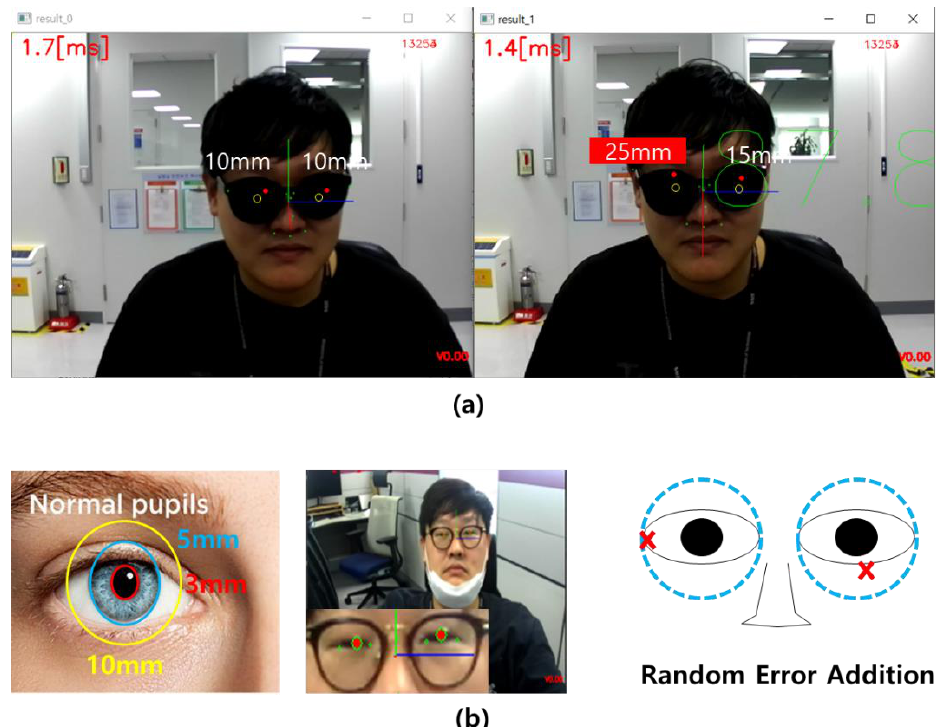
Figure 8. Participant-based experiments assessing the susceptibility of the proposed method to 3D crosstalk for users wearing sunglasses. ( a ) Examples of eye-tracking precision error of 10 mm (left), 15 mm, and 25 mm (right). ( b ) Eye-tracking precision error was calculated using the distance between the center of pupil center and tracked eye position (left). An example of a bare-face eye-tracking result with a precision of 2 mm (middle). To validate 3D crosstalk with a large eye-tracking error of 10 mm, we added a random eye-position error (right). Users experienced 3D crosstalk when the eye-tracking precision error was >15 mm. For the current 3D HUD prototype, the 3D crosstalk was low with an eye-tracking precision error of <10 mm.